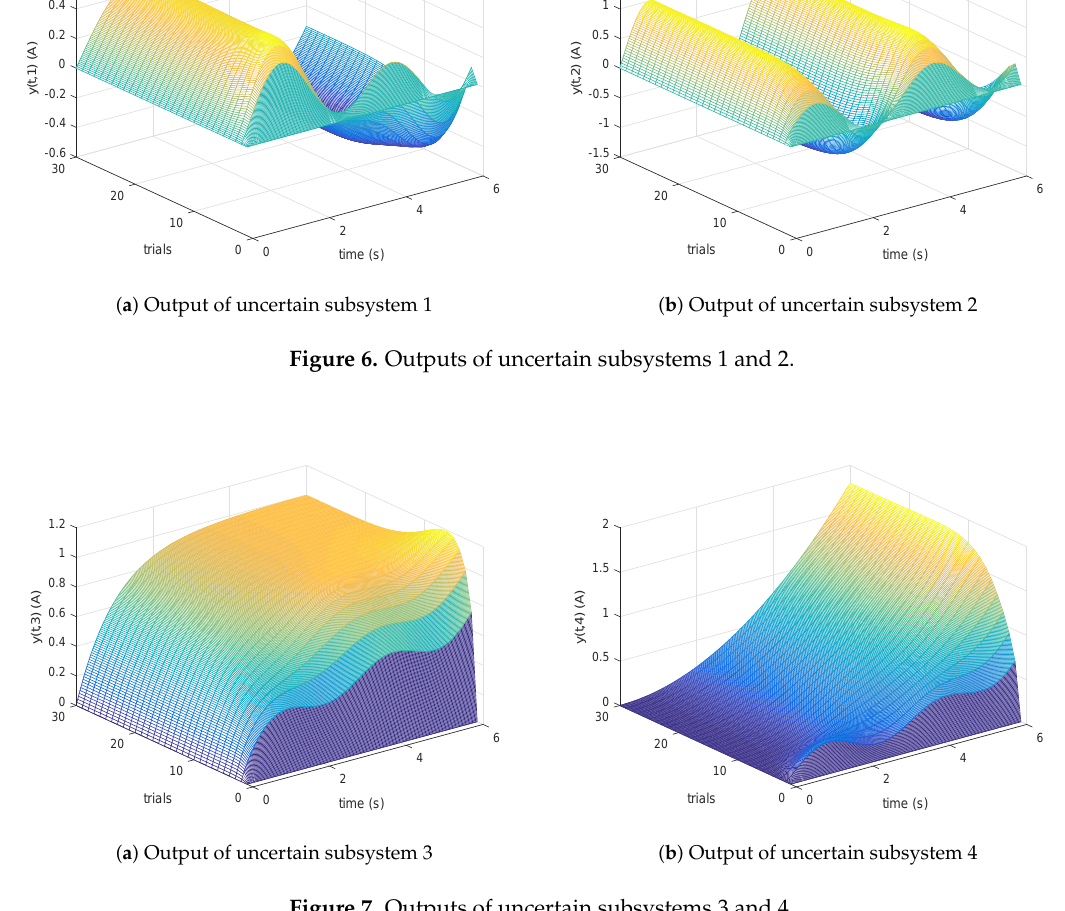
Figure 7. Outputs of uncertain subsystems 3 and